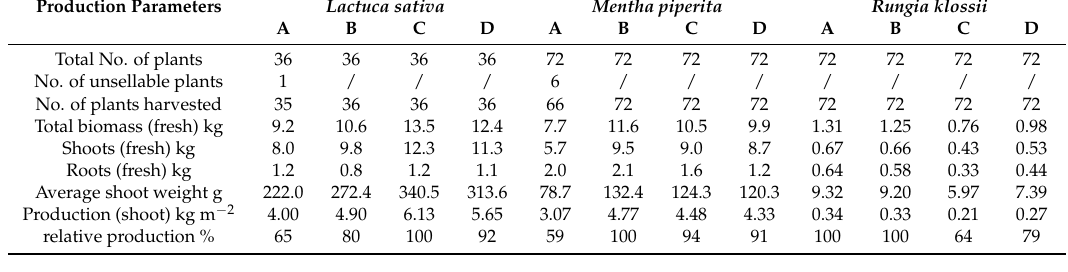
Total No. of plants